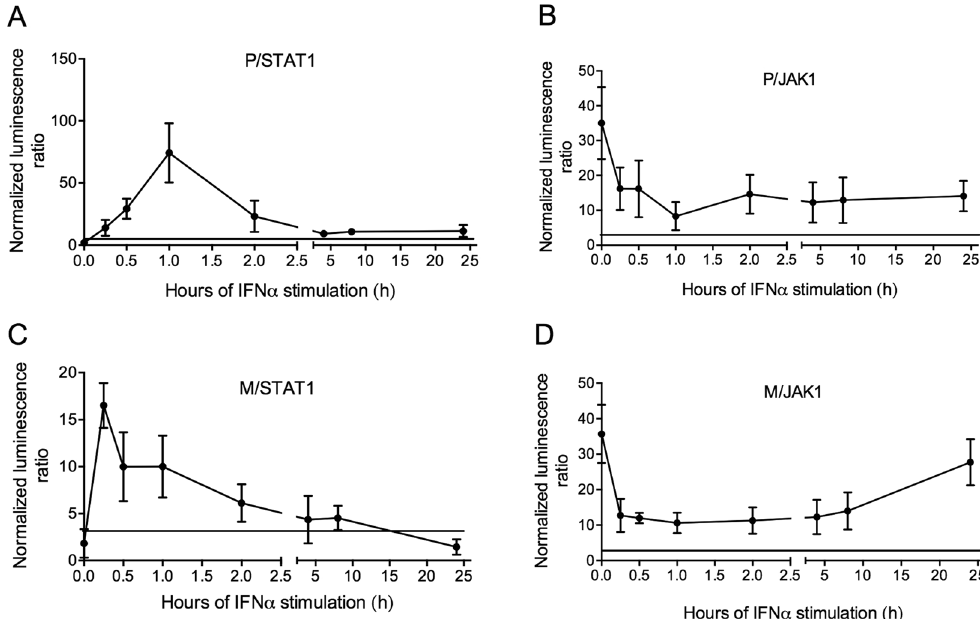
Figure 6. Dynamic interactions between RABV P and/or M proteins and pSTAT1 and Jak1 proteins. Protein complementation assay: P and M proteins were co-transfected with STAT1 or JAK1-coding plasmids. Two days post-transfection, cells were stimulated with IFN α for 15 or 30 min, or 1, 2, 4, 8 or 24 h. Gaussia luciferase activity, whose intensity corresponds to interaction, was determined. The bold horizontal lines represent the Gaussia significance threshold. Results are expressed as means ± standard deviation (T-bars) of five independent